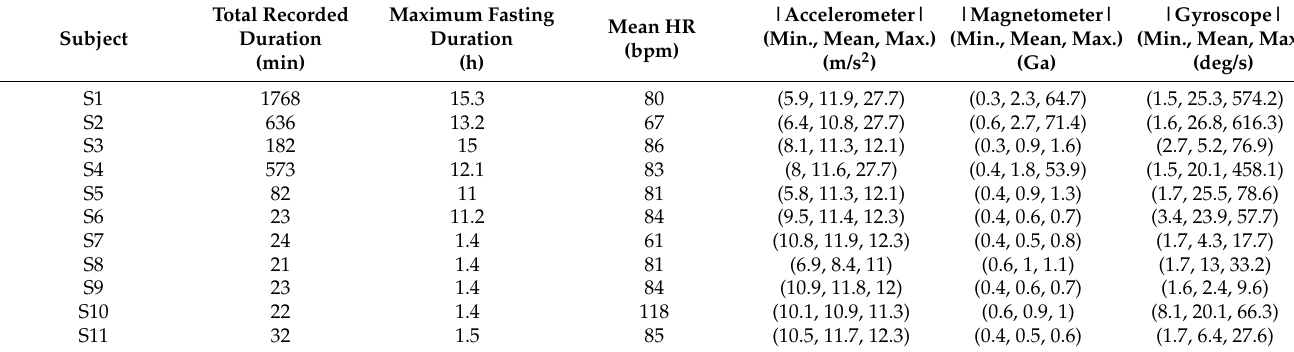
Table 1. Descriptive statistics for the collected dataset.